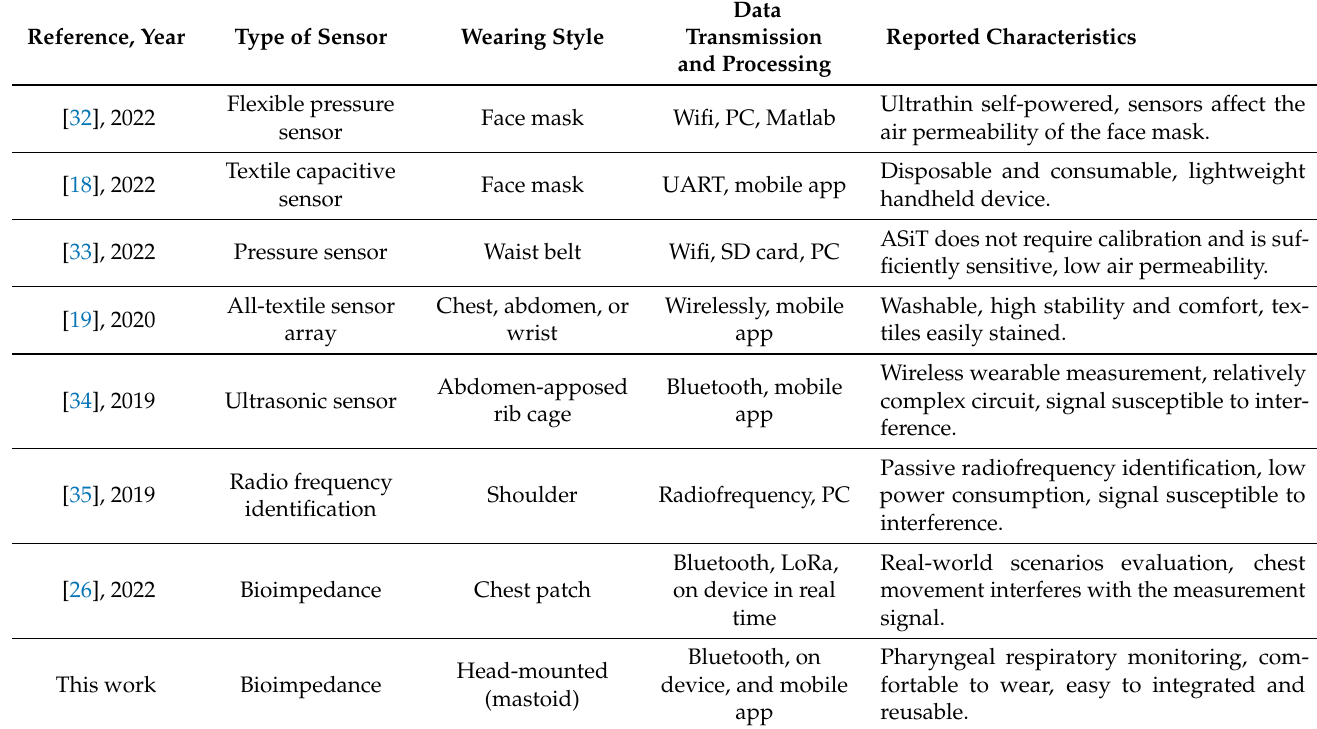
Table 3. Comparison of respiratory monitoring wearable